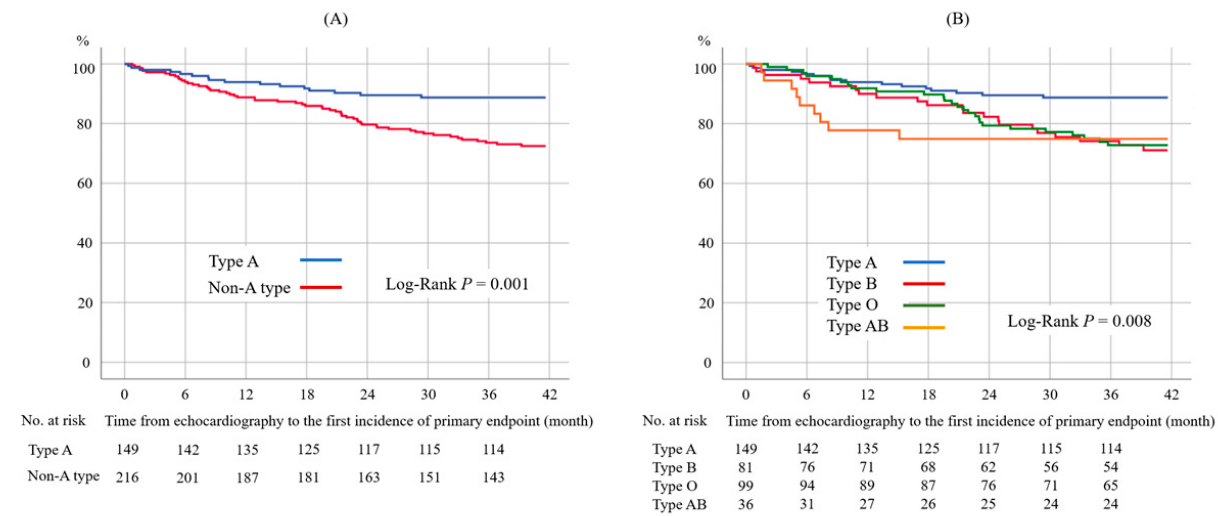
Figure 1. Kaplan–Meier curves for the primary endpoint according to type A or non-A type ( A ) and each blood type ( B ). Patients with dialysis and blood type A had a significantly lower incidence of the primary endpoint compared to those with dialysis and non-A type.